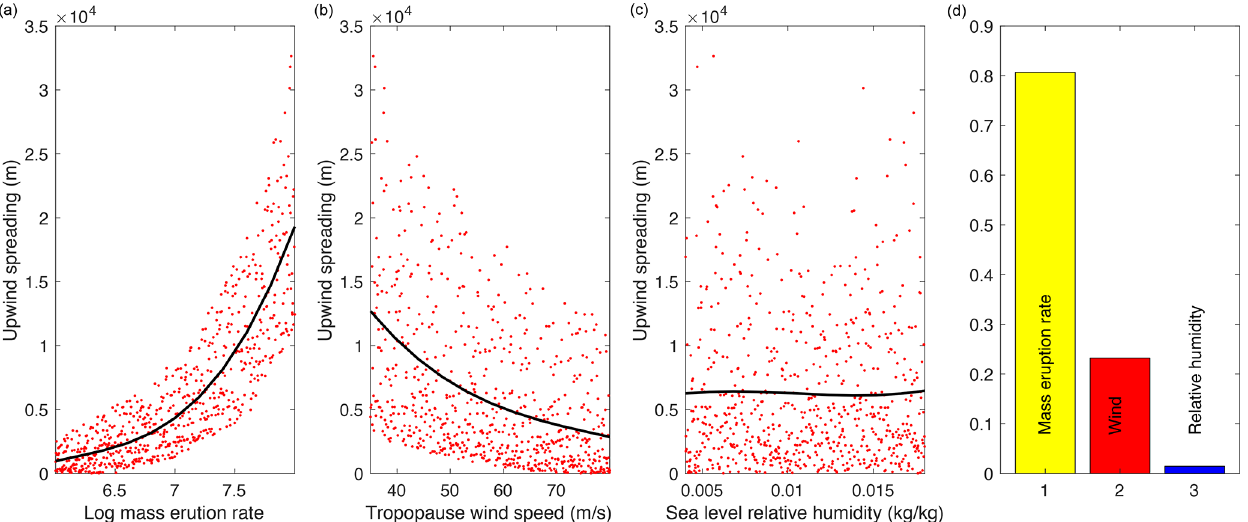
Figure 11. Upwind spreading of the umbrella cloud as a function of input parameters (a–c) and main sensitivity indices (d) . In the first three panels, each red dot represents a different simulation, whereas the black lines represent the mean of the output parameter at a given input value. For a fixed value of the input parameters on the x axis of a plot, the vertical spreading of the results is associated with variations in the other input